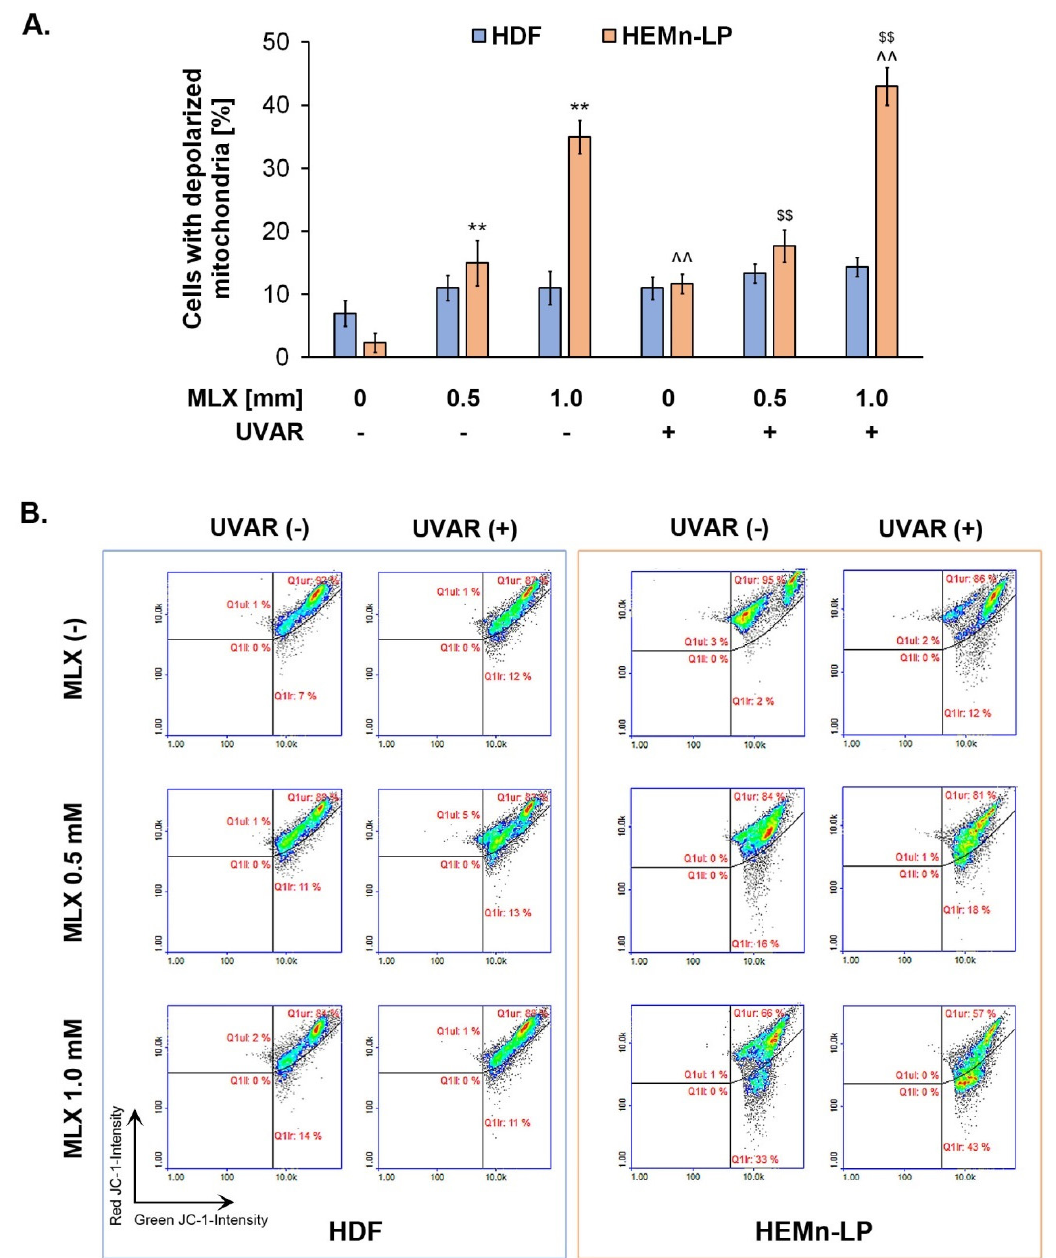
Figure 4. The changes in mitochondrial transmembrane potential in fibroblasts and melanocytes after treatment with MLX and/or UVAR. ( A ) Bar graphic representing cells with depolarized mitochondria; ( B ) Representative scatter plots presenting the changes in JC-1 density in analyzed cell cultures. ** p < 0.01 vs. untreated cells (control), $$ p < 0.01 vs. irradiated cells (not treated with meloxicam), ^^ p < 0.01 vs. corresponding sample not treated with UVAR.